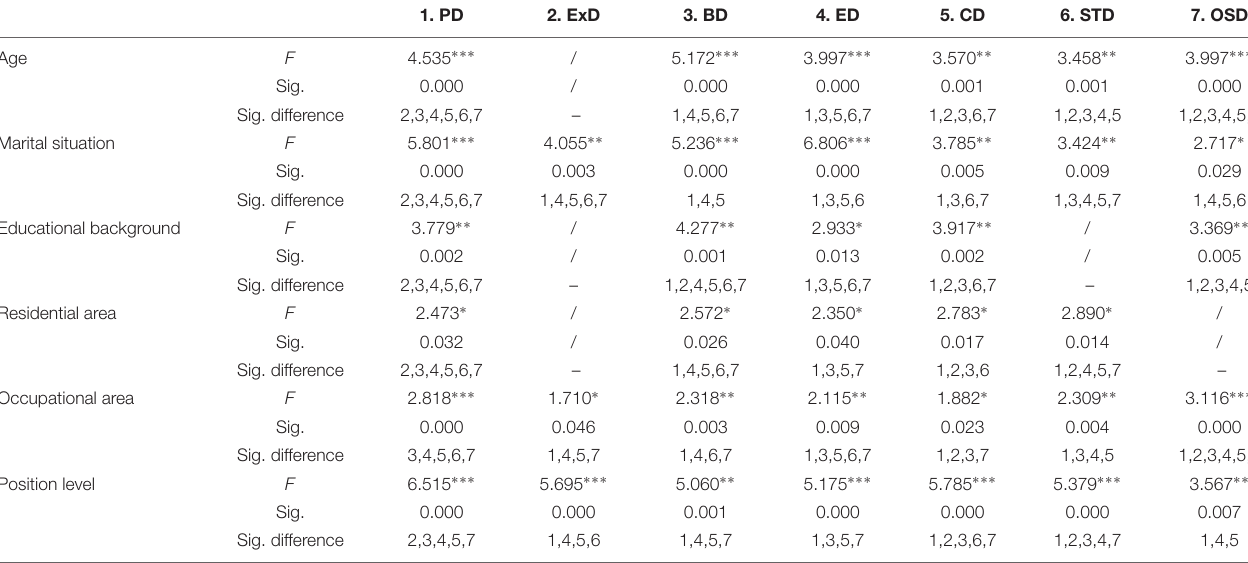
TABLE 4 | Difference analysis and multiple-comparison analysis of EOPD and each dimension on demographic